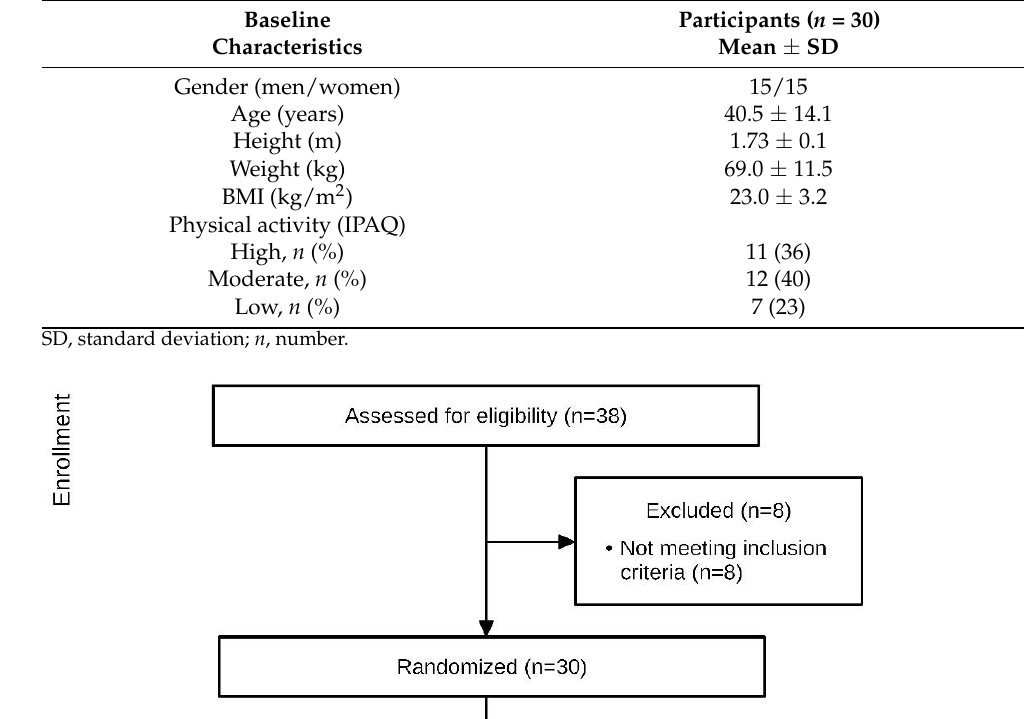
Table 1. Baseline characteristics.